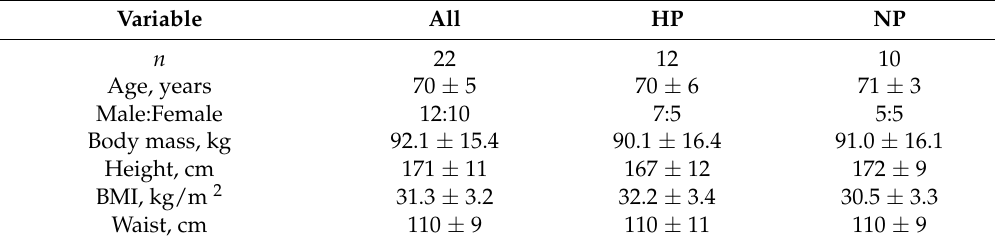
Table 2. Baseline participant characteristics 1